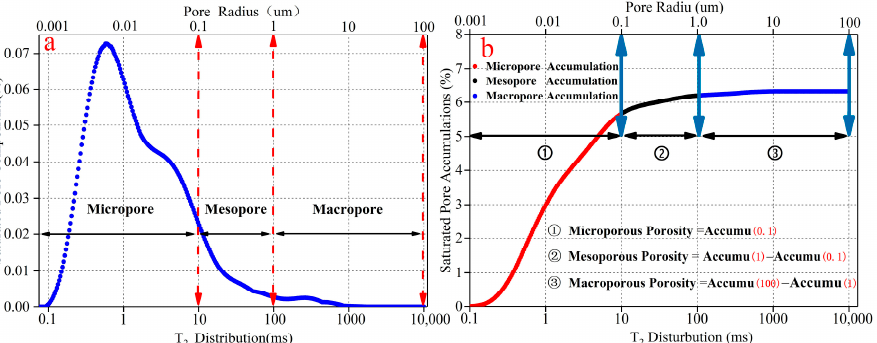
Figure 2. Pore radius dividing and porosity dividing. ( a ) is the pore radius dividing. ( b ) is the porosity dividing.